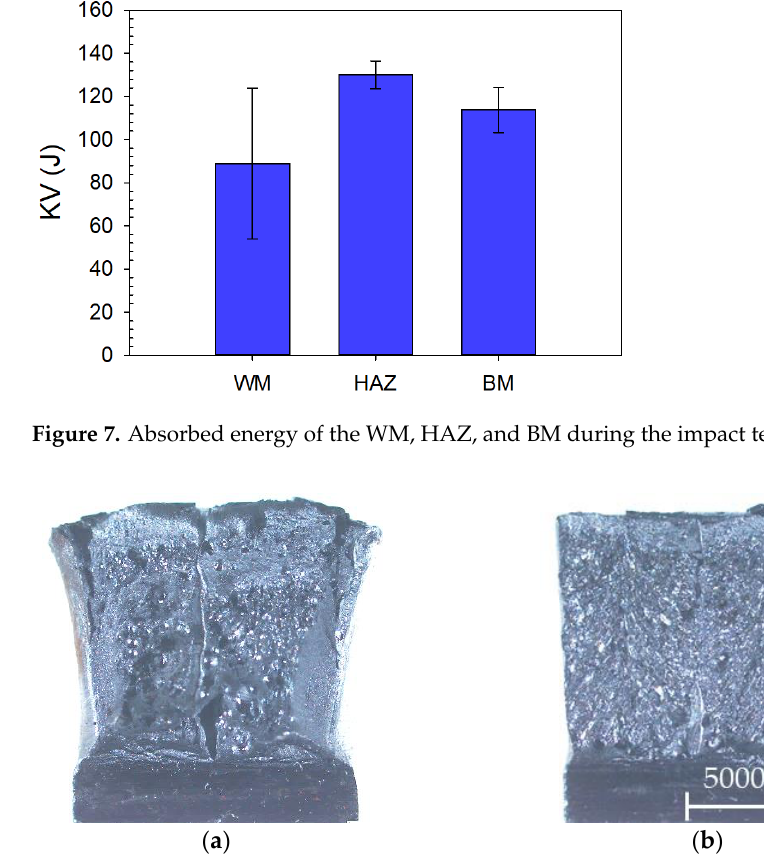
Figure 8. Differences in the fracture morphology of the WM samples: ( a ) 42 J and ( b ) 125 J.